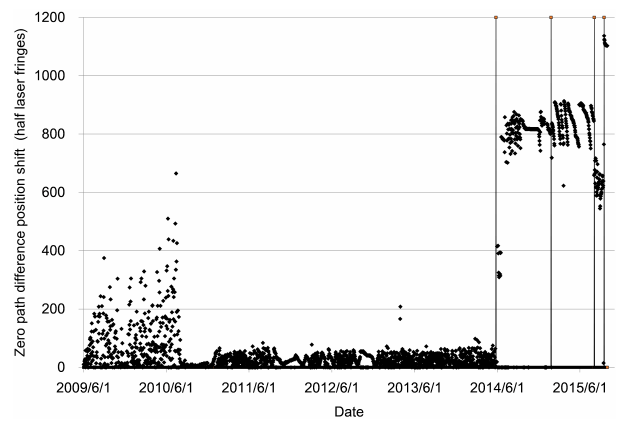
Figure 2. Long-term ZPD position from the center of the interfero- gram with periodic correction operations. The optical center of the interferogram is 38273 half laser fringes. The vertical lines repre- sent the time of three major system anomalies: solar paddle, point- ing mechanism change, and cryocooler suspension and restart.